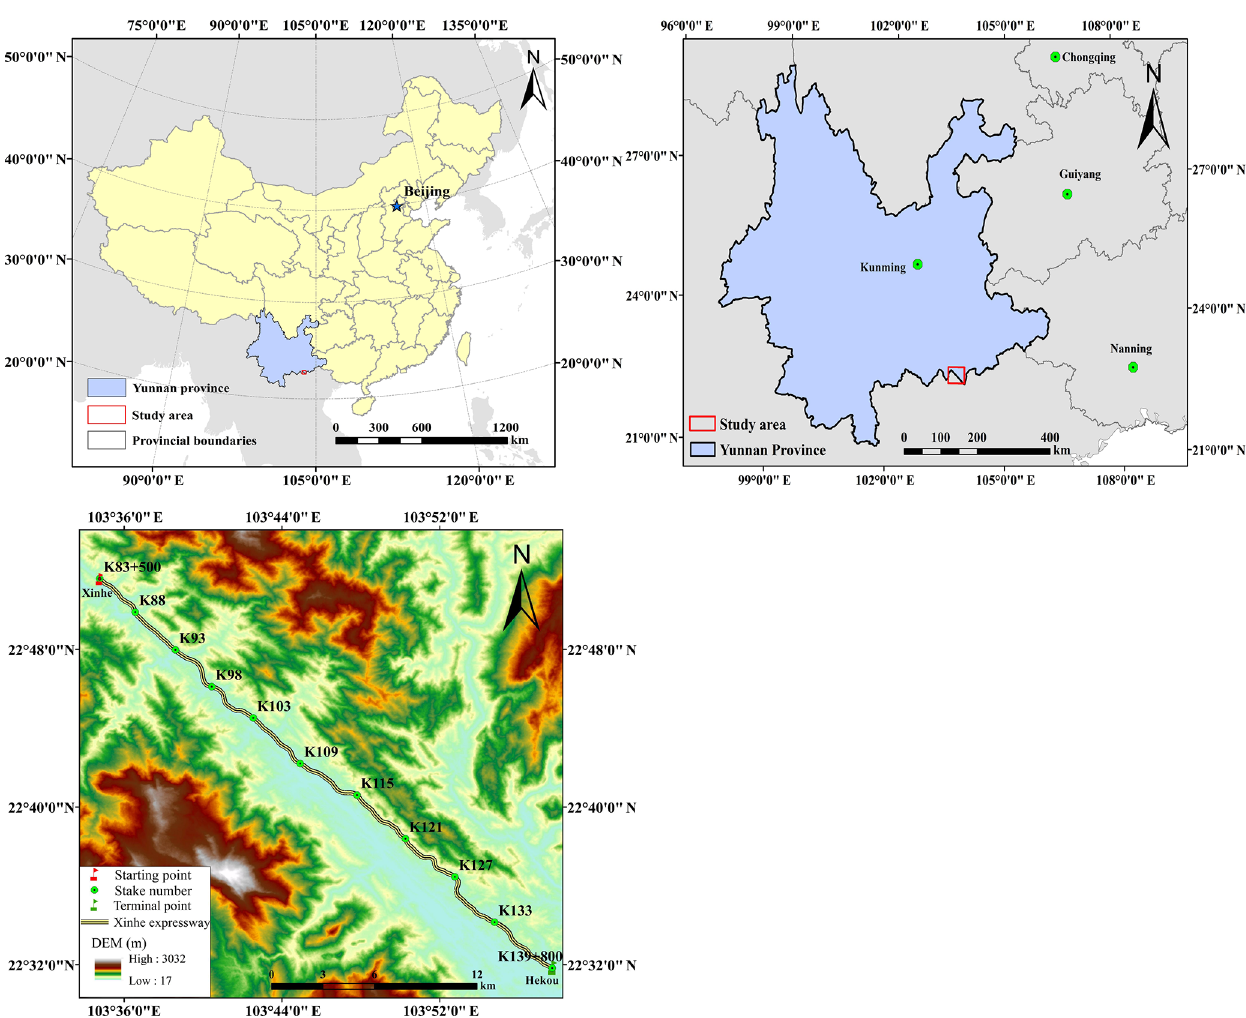
Figure 2. The location and the overview of the study